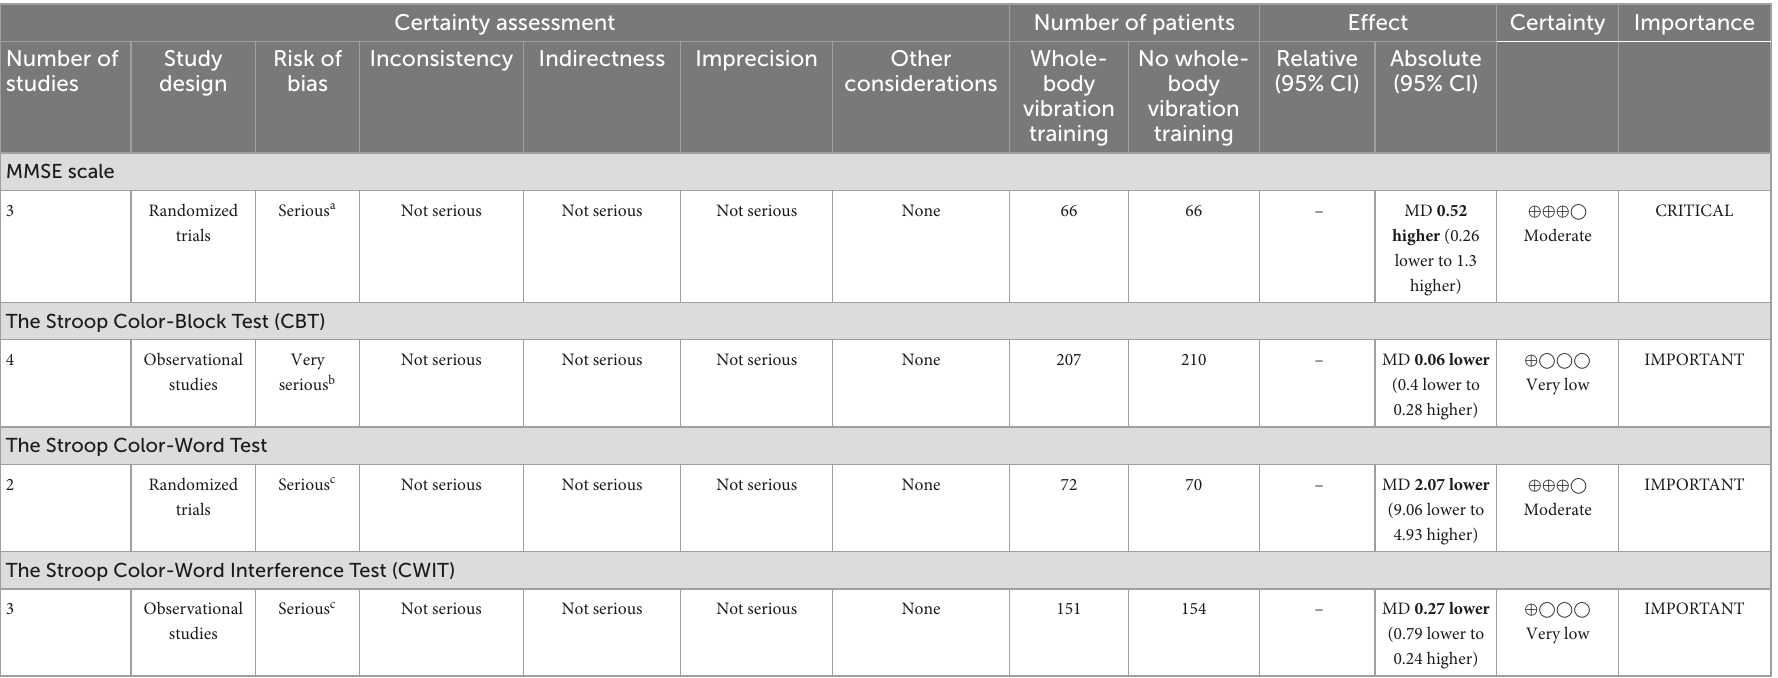
TABLE 3 Evidence summary form of the